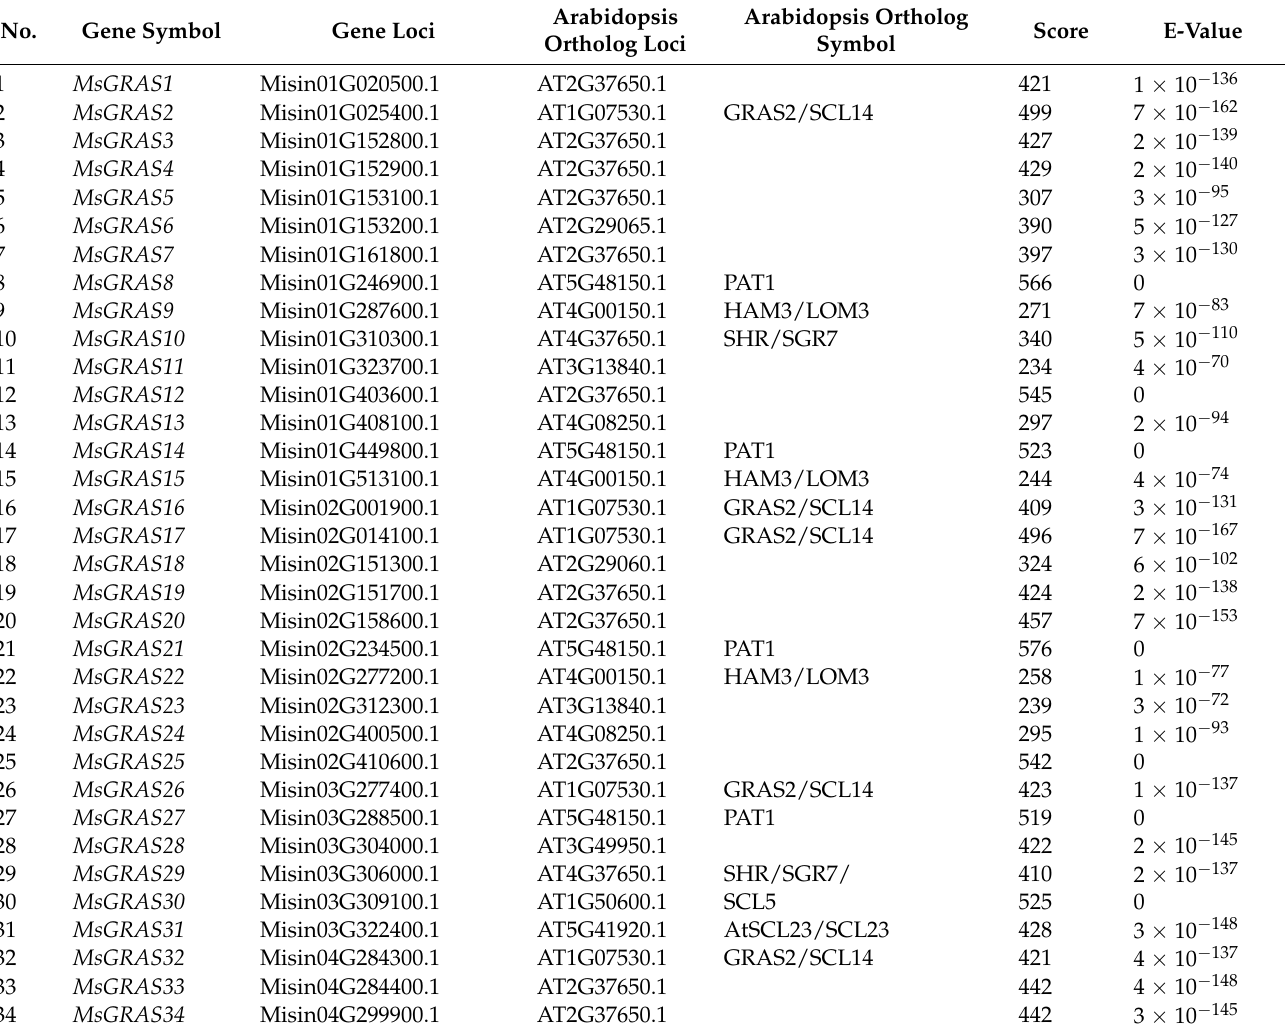
Table 1. List of MsGRAS genes and their closest orthologs to